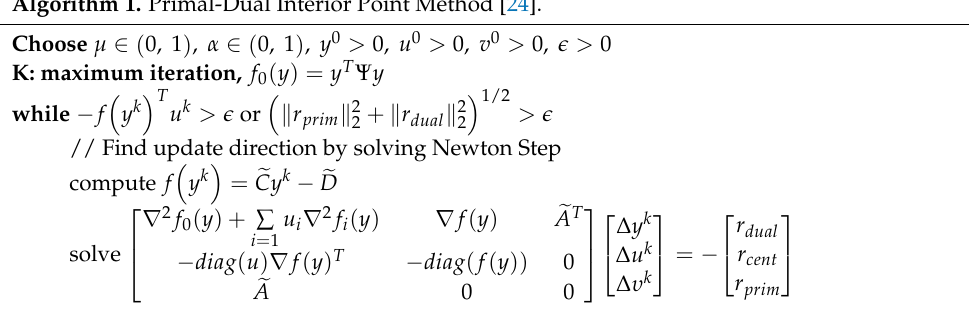
Algorithm 1. Primal-Dual Interior Point Method